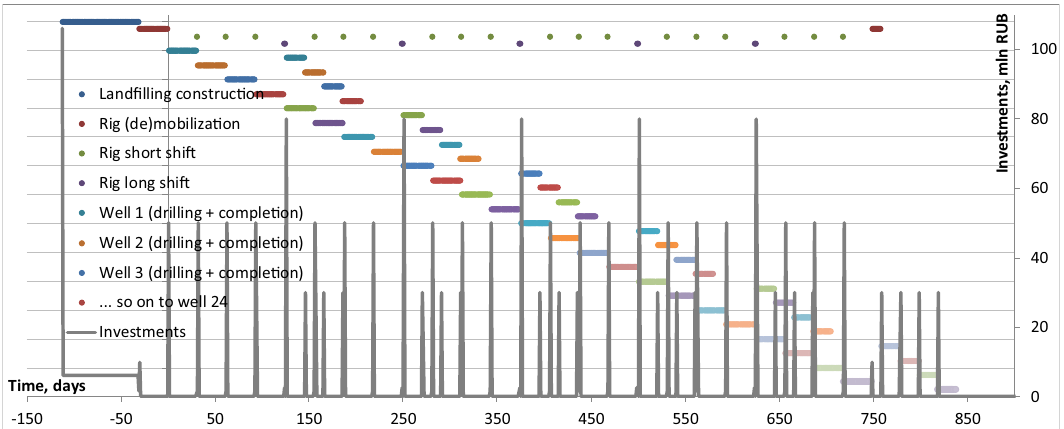
Fig. 4 Scenario 1 reference design well pad construction, drilling and completion schedule with corresponding investments (the horizontal lines show time intervals of operations; vertical lines show amount of invested funds; names of operations are given in the legend; differ-